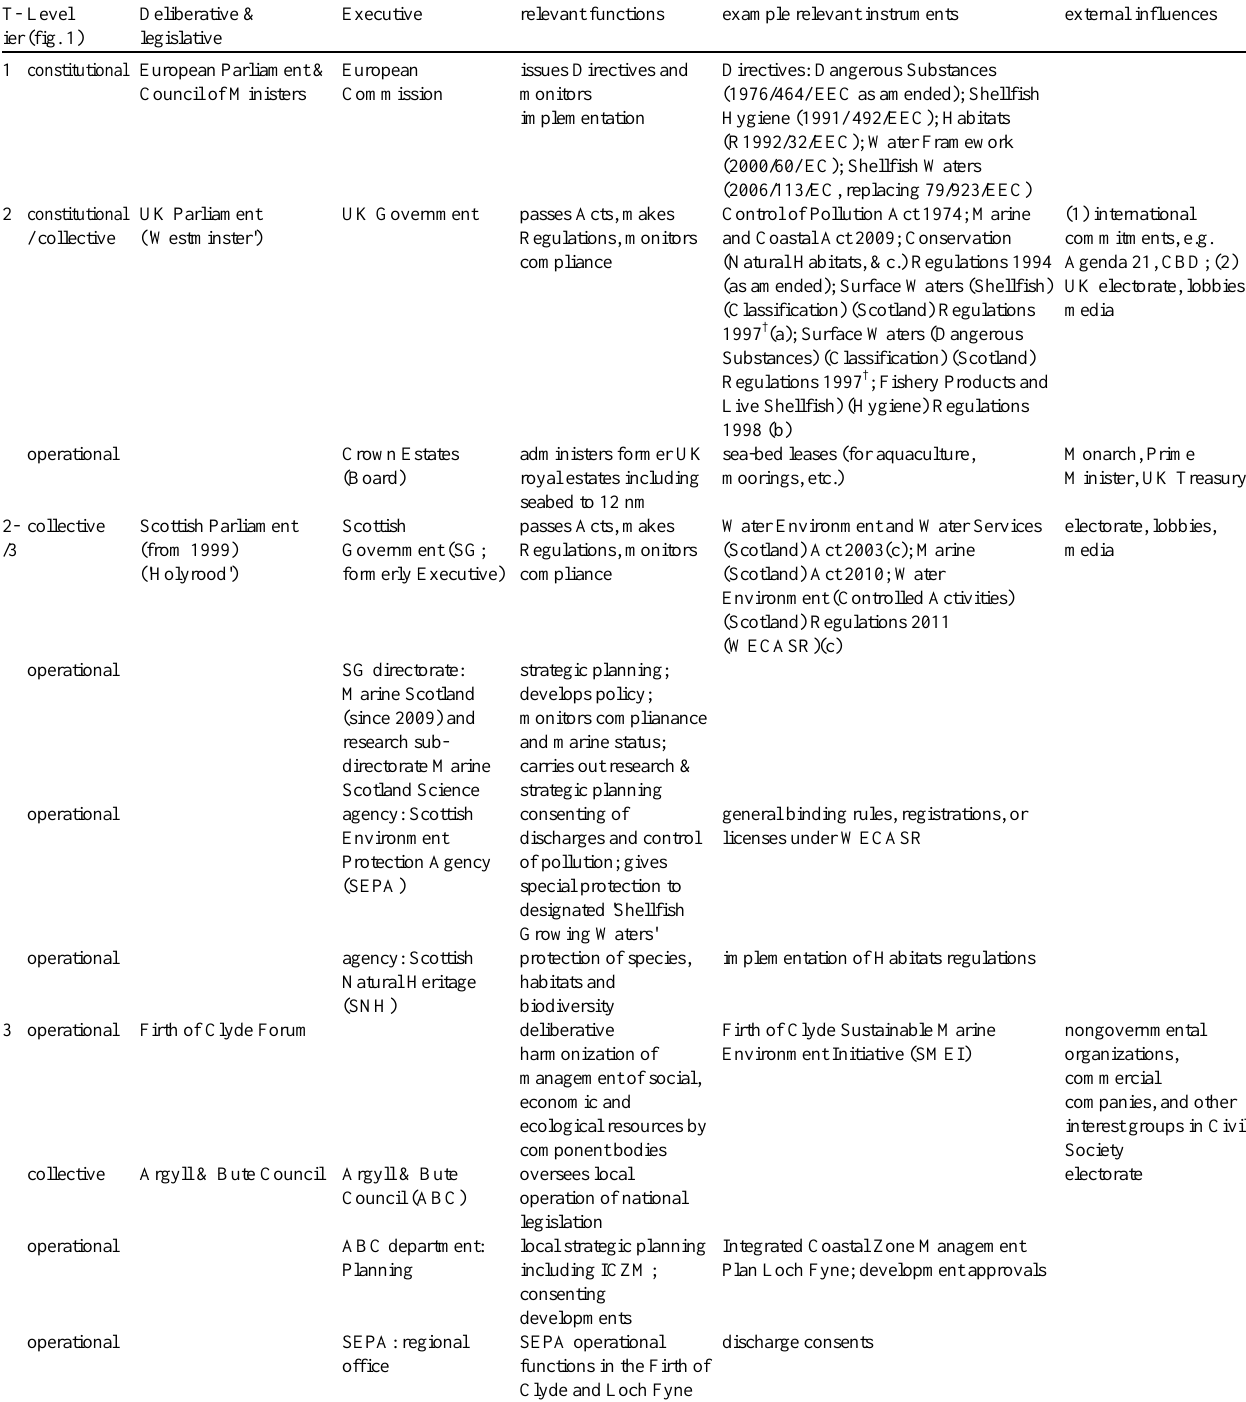
Table 1 . Institutions of Governance relevant to matters described this paper T- Level ier (fig.